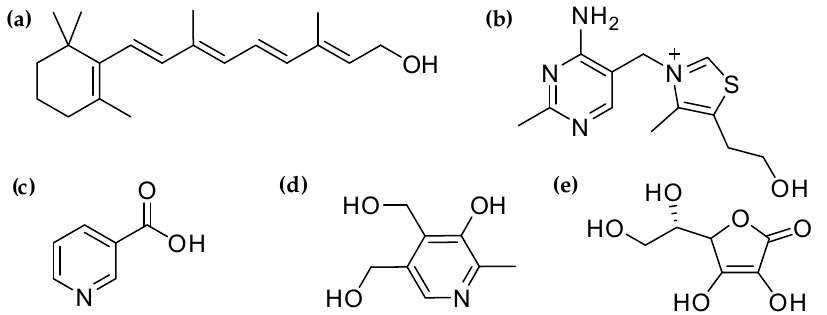
Figure 1. Dietary vitamins; ( a ) vitamin A, ( b ) vitamin B1, ( c ) vitamin B3, ( d ) vitamin B6, and ( e ) vitamin C.